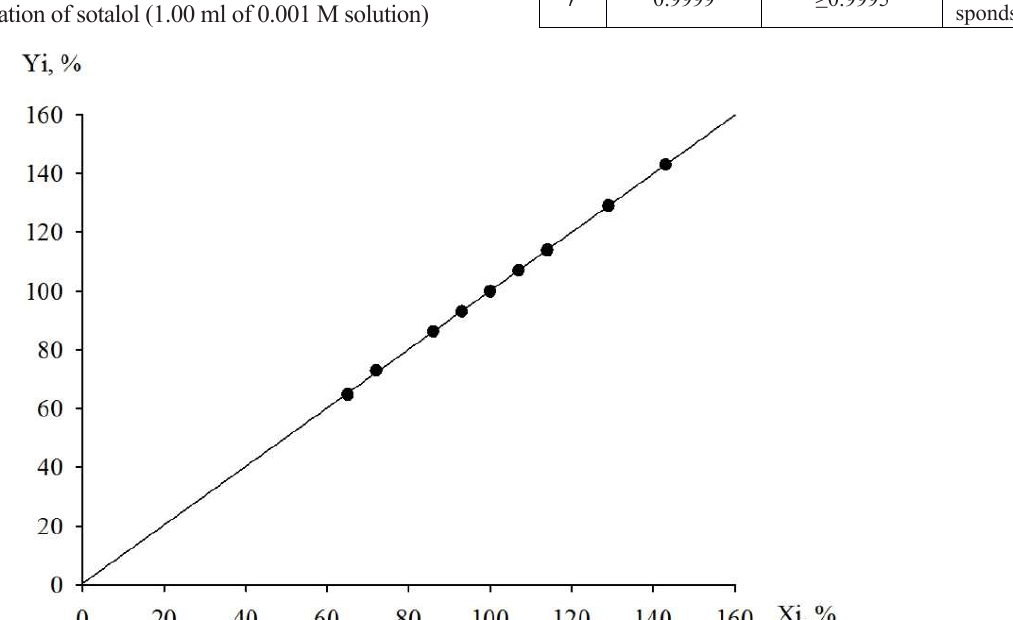
Fig. 5. Saturation curves: 1 – sotalol solution at a constant concentration of reagent (1.00 ml of 0.001 M solution), 2 – diazole red 2J at a constant concentration of sotalol (1.00 ml of 0.001 M solution)